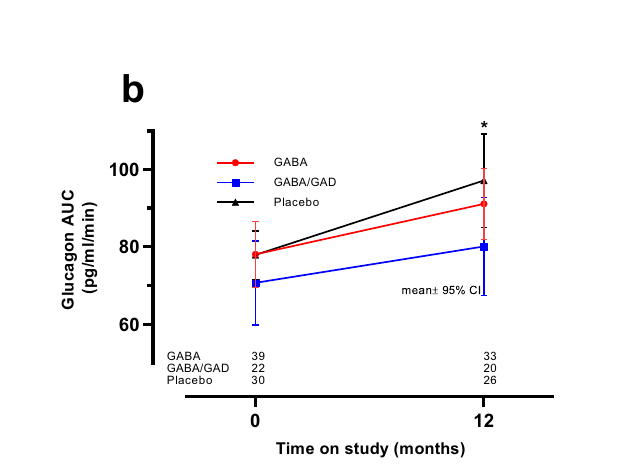
Fig. 4 | Fasting and AUC glucagon in study groups over time. Fasting glucagon ( a ) was measured in the three study groups (GABA-red, GABA/GAD-blue, and pla- cebo-black) at baseline (Time=0, prior any treatment) and at 1, 5 and 12-months thereafter. AUC glucagon ( b ) was calculated over time in the three study groups. Resultsaregivenasmean±95%CI.Statisticaldifferenceswerebytwo-sidedanalysis